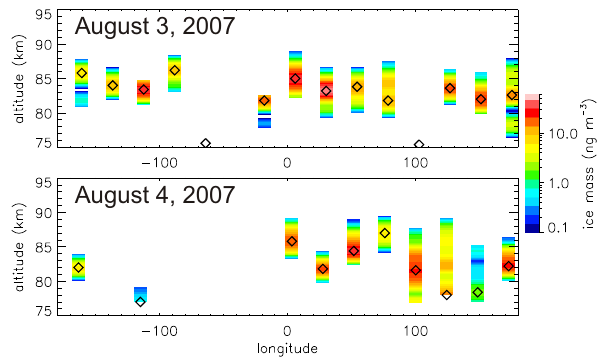
Fig. 5. Sky brightness observed from Juliusruh on 4 August,